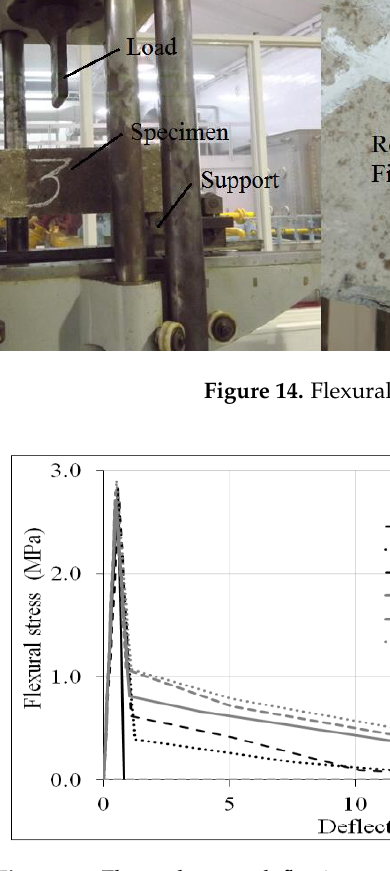
Figure 15. Flexural stress–deflection curves of control samples and concrete samples with recycled PET fibres.